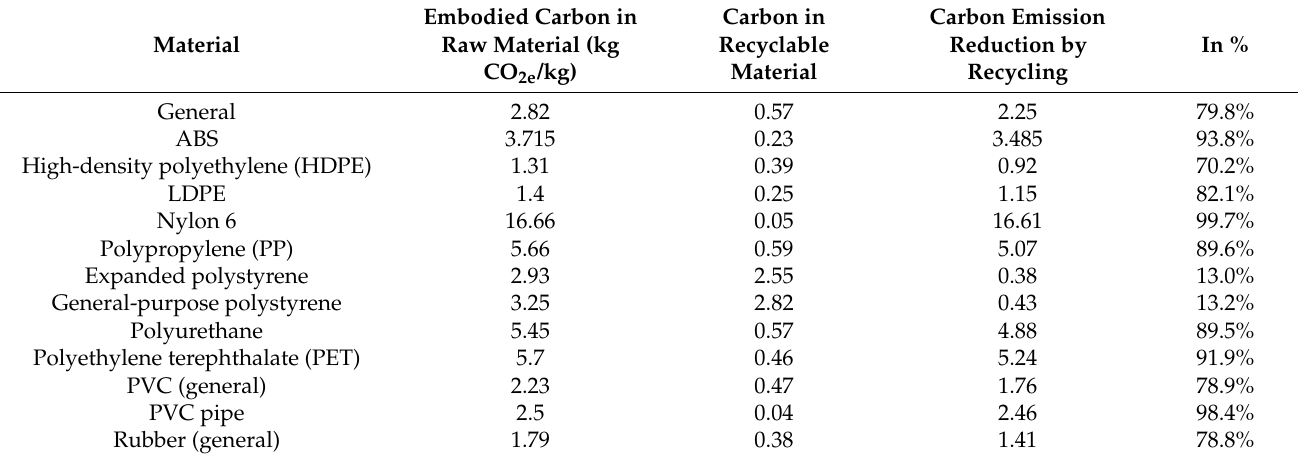
Table A2. Differences between the embodied carbon in the raw material vs. the carbon contained in the recyclable material [82]. Embodied Carbon in Material Raw Material (kg